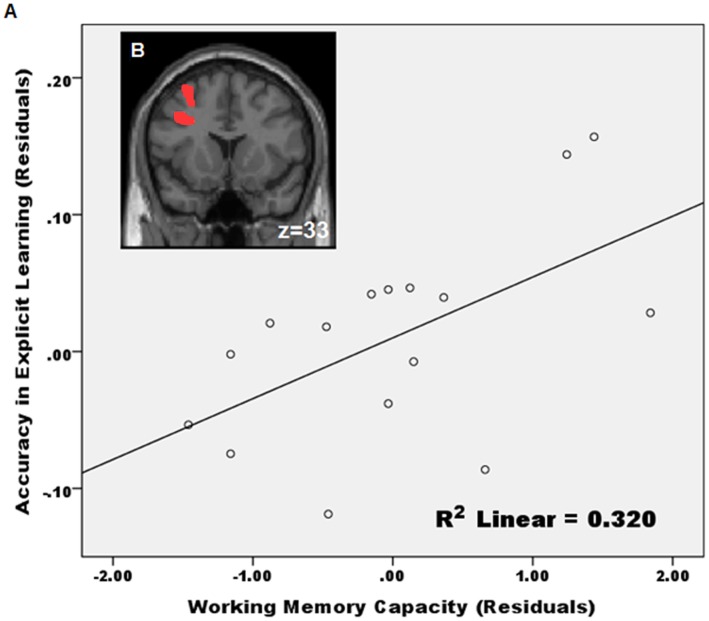
Role of working memory in explicit learning.Working memory capacity in the explicit group showed a positive correlation with behavioral cognitive performance, as seen in (a), and with functional brain activation, as seen in (b), during grammaticality judgment. Residuals were calculated from a partial correlation analysis after controlling for age effects. See text for explanation.